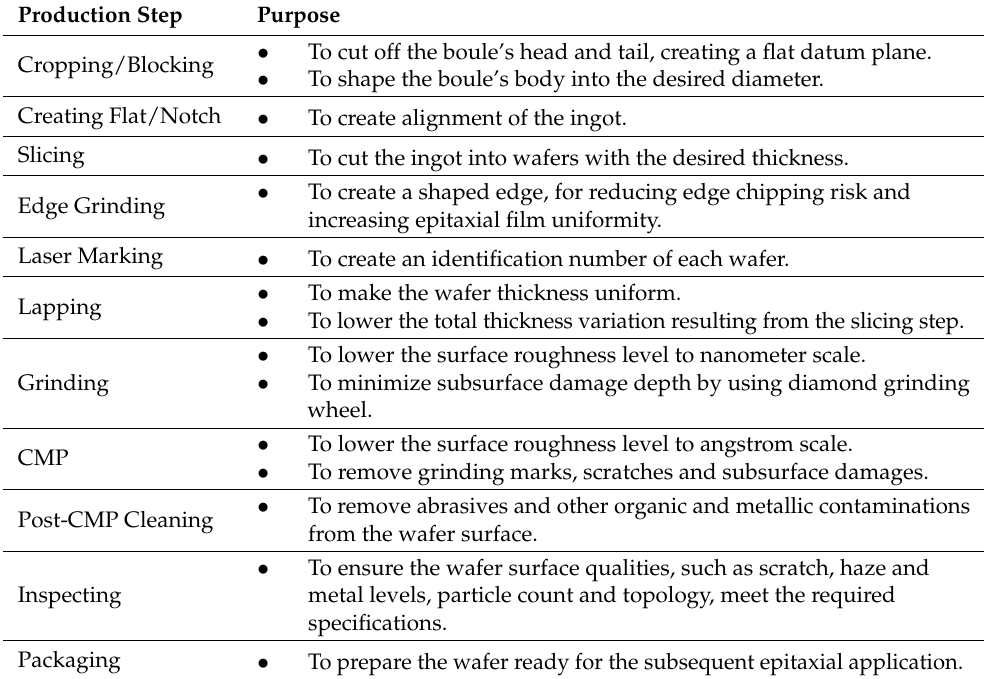
Table 1. SiC wafer production steps and the purposes. (Ref. CMC Materials Co., Kaohsiung City,